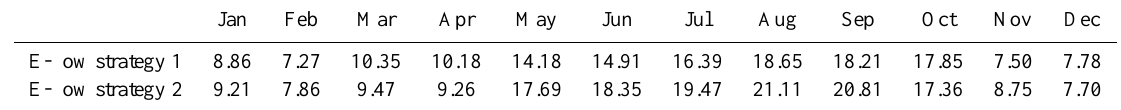
Table 2. Optimised monthly volume of hydropower in the contract for the Wangkuai Reservoir ( × 10 5 kwh). Jan Feb Mar Apr May Jun Jul Aug Oct E-flow strategy 1